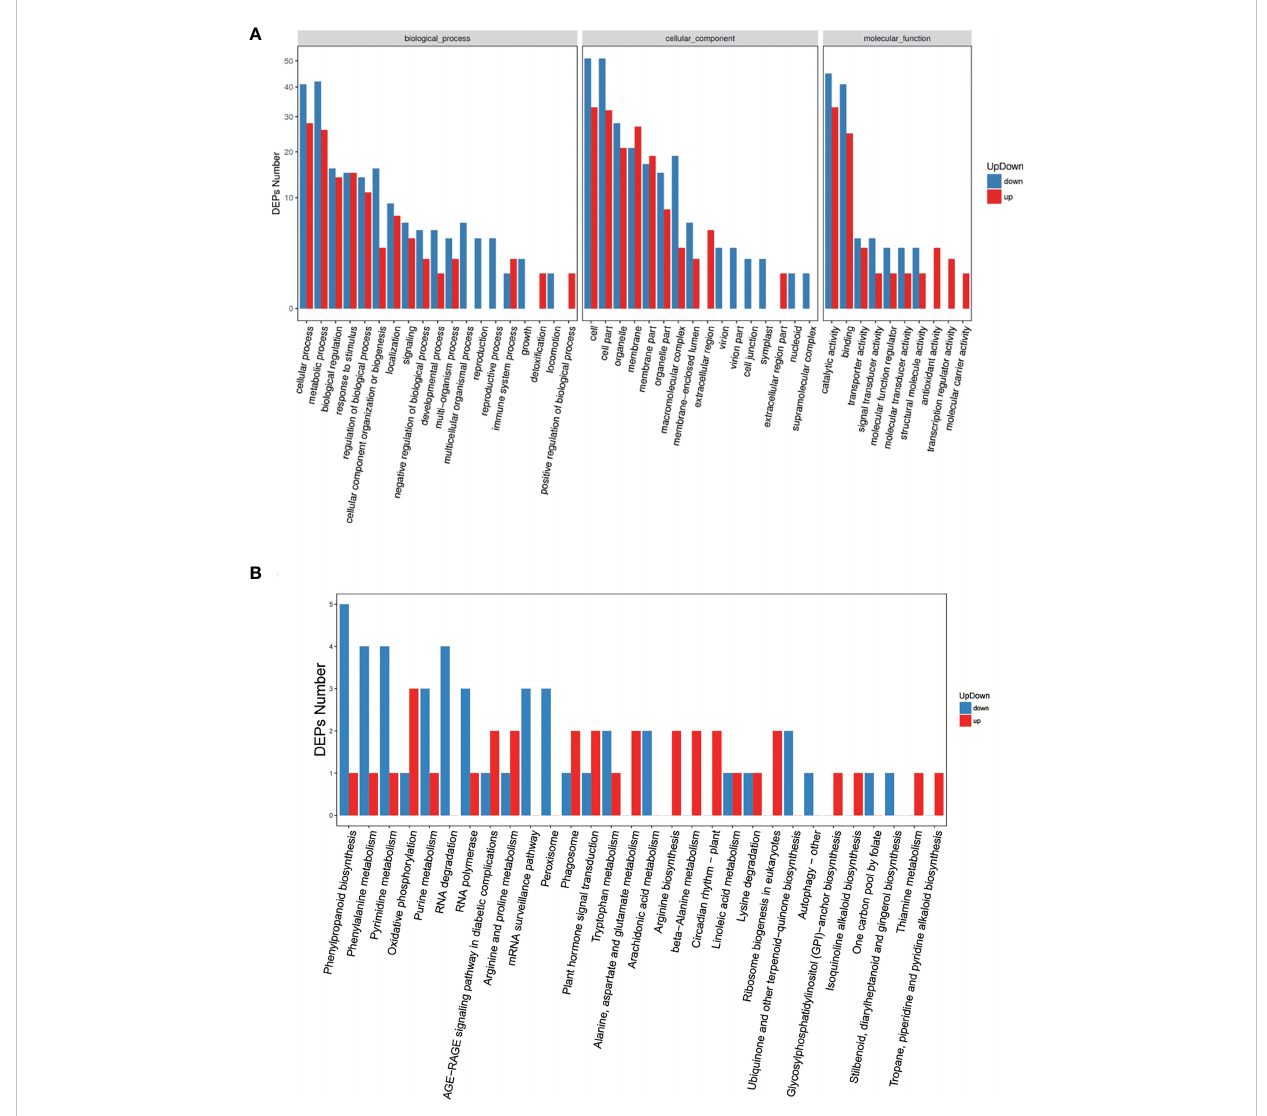
FIGURE 4 GO and pathway enrichment analyses for all signi fi cant DEPs. (A) Gene ontology analysis of DEPs, x-axis displays GO term, y-axis displays protein count 。 (B) Pathway analysis of DEPs, x-axis displays pathway name, y-axis displays DEP